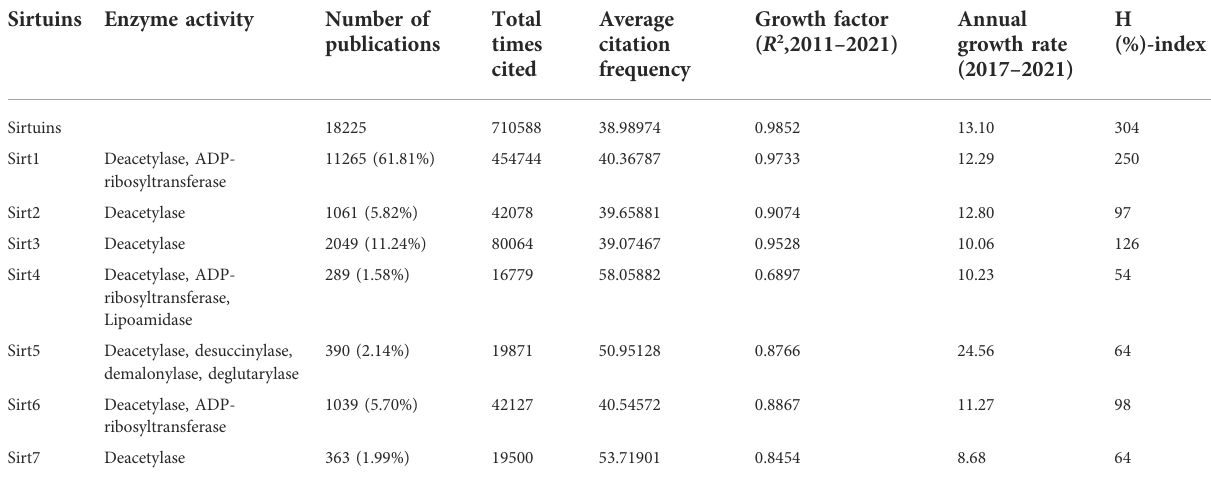
TABLE 2 Overall distribution of publications in sirtuin family. Sirtuins Enzyme activity